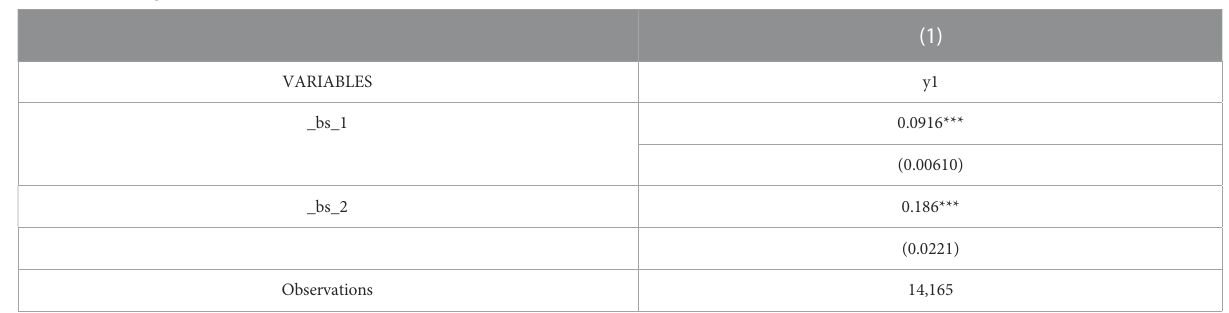
TABLE 7 Bootstrap